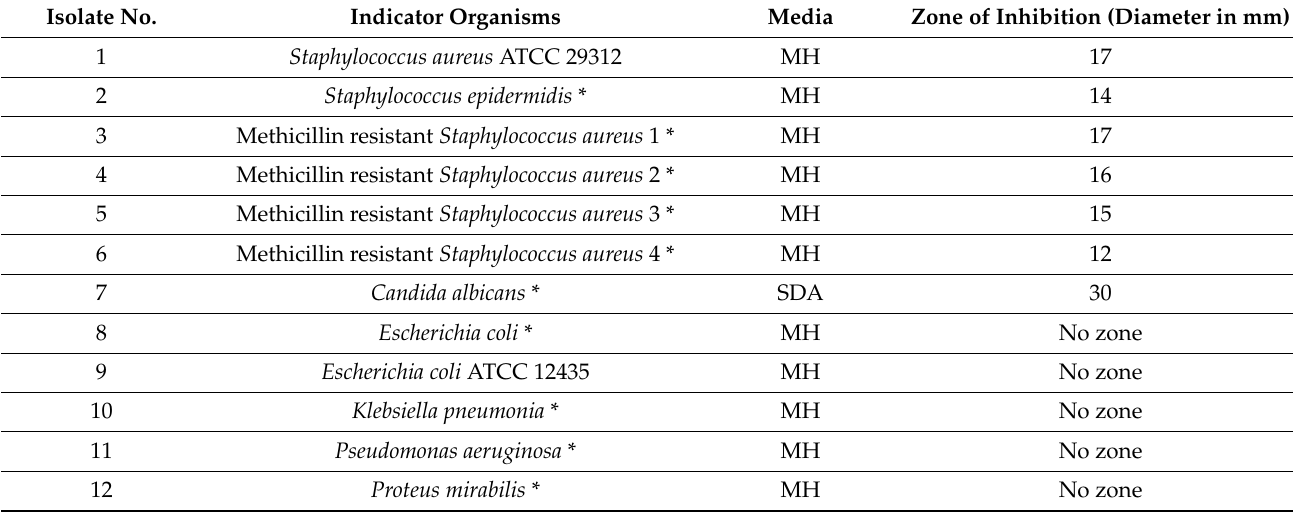
Table 2. Summary of the antimicrobial activity spectrum of the supernatant of Bacillus sp . using cut-well agar diffusion assay. Isolate